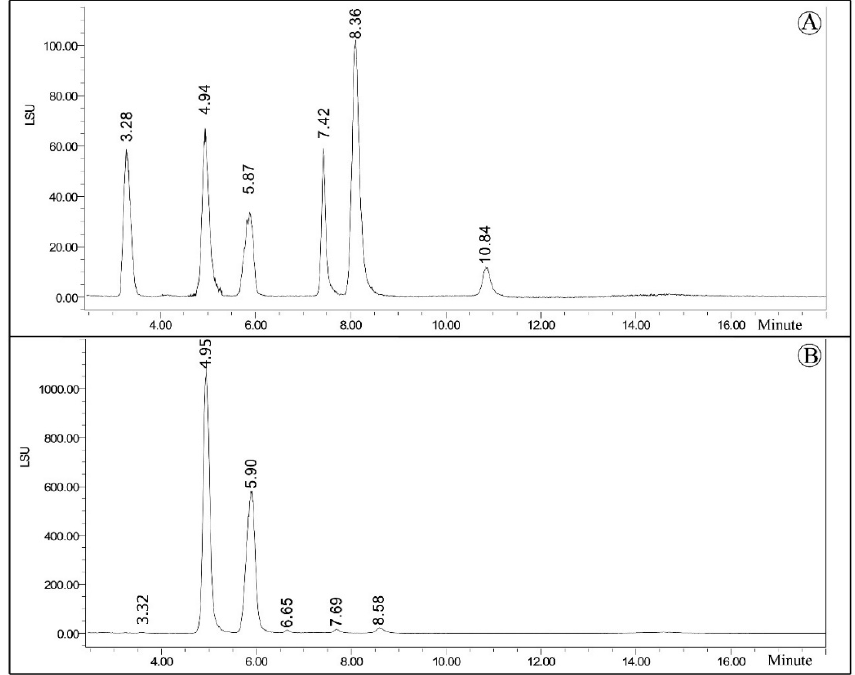
Figure 3. UPLC-ELSD chromatograms of free sugar standards ( A ) and wood apple ( Limonia acidissima L.) fruit pulp ( B ). Table 3. Free sugar composition (%) of wood apple defatted fruit pulp 1 .